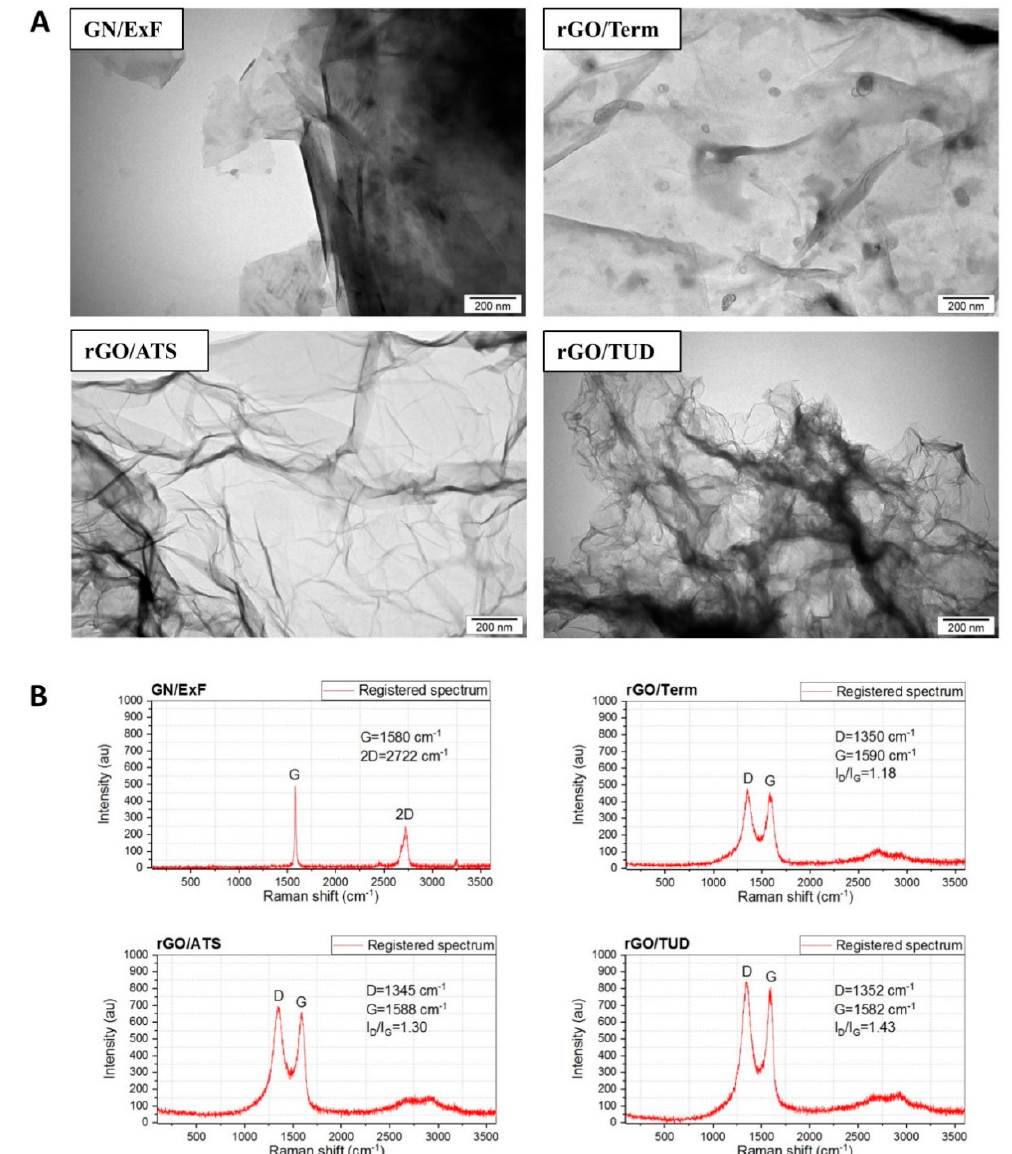
Figure 1. Transmission electron microscopy (TEM) images and Raman spectra of GN and rGO flakes. ( A ) Images of GN/ExF flakes and three types of rGO (rGO/ATS, rGO/Term, and rGO/TUD). ( B ) Spectra consist of three bands: D band located at ~1350 cm − 1 , G band at ~1580 cm − 1 , and 2D band at ~2700 cm − 1 . G band is characteristic of each graphene sample. The appearance of the D-band is typical of rGO samples because some oxygen functional groups remain after the reduction of GO. A strong 2D band only appears for graphene (GN); for rGOs, the 2D band occurs as a weak and broad signal. Abbreviations: rGO, reduced graphene oxide; GN, graphene.